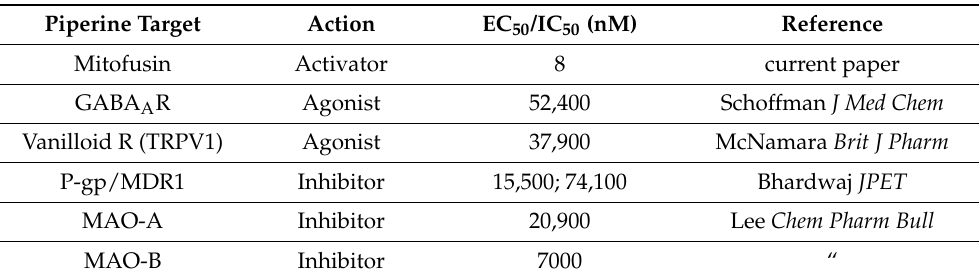
Figure 3. Piperine screening in WT, Mfn1 KO (knockout), Mfn2 KO, and DKO (double knockout) MEFs. Effects of piperine (100 nM) added to cells overnight were assessed on mitochondrial aspect ratio (left; MitoTracker Green staining) and depolarization (right; TMRE staining). Each point represents the average of 8–10 cells from one of three biological replicates. Means ± SEM are shown. p values used t -test. Table 1. EC 50 /IC 50 values for piperine at reported targets.